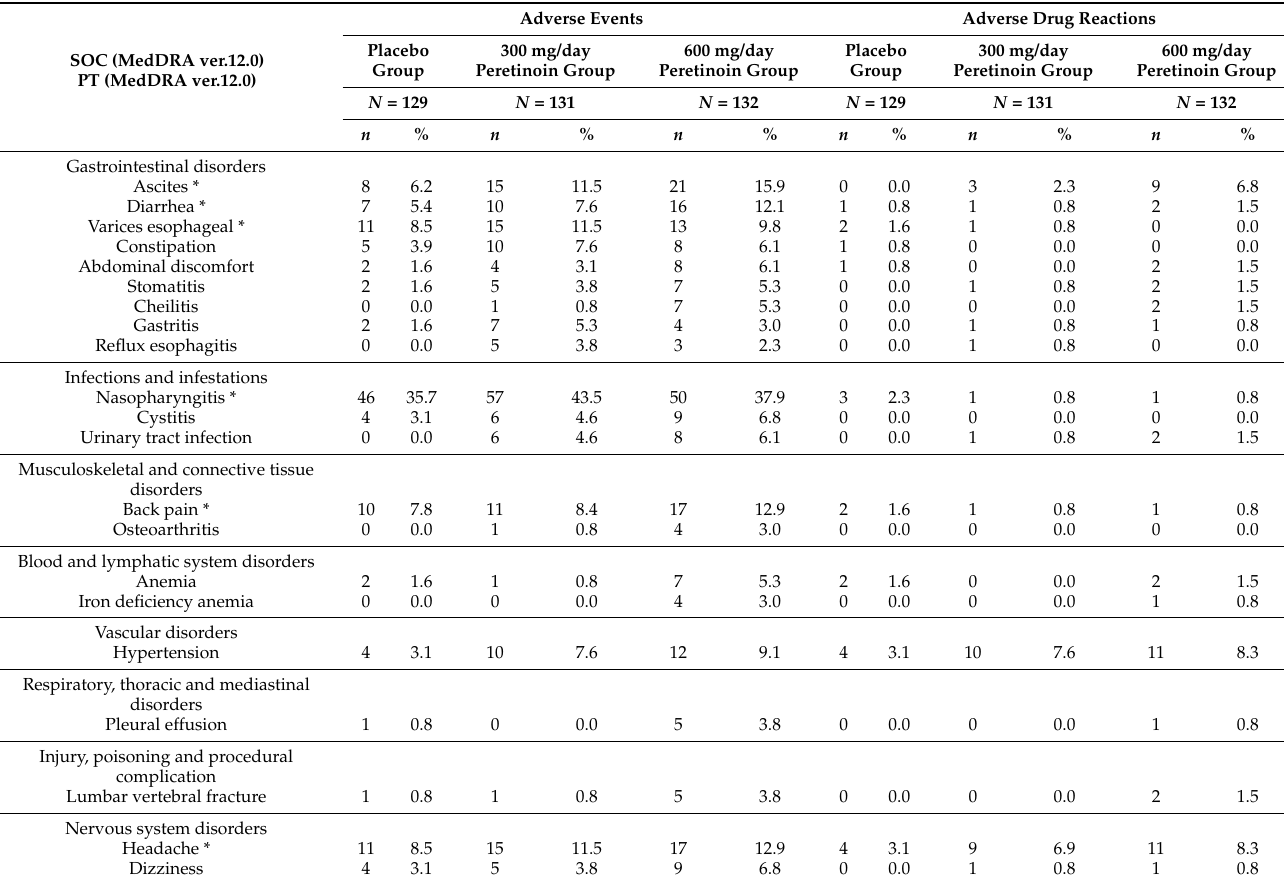
Table 2. Adverse events and adverse drug reactions of incidence ≥ 3% higher in the peretinoin groups than in the placebo group (specific adverse